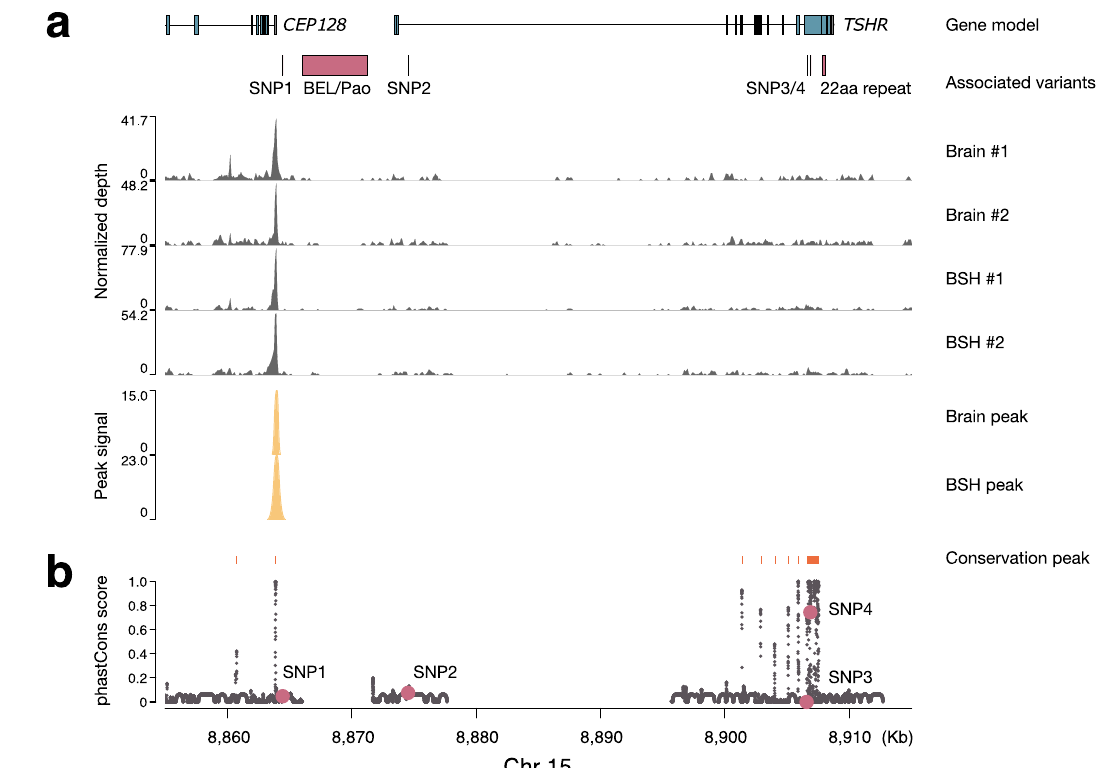
Fig. 3 ATAC-seq and sequence conservation analysis for the herring TSHR locus. a ATAC-seq signals in herring hypothalamus and saccus vasculosus (BSH) and brain without BSH (brain). Genomic locations of two annotated genes at this locus, CEP128 and TSHR , are indicated together with the six highly differentiated variants between spring- and autumn-spawning herring, including two non-coding SNPs (SNP1 and 2), two coding SNPs (SNP3 and 4), the 5.2 kb BEL/Pao structural variant and the 22aa copy number variant at the C terminus of herring TSHR. b Sequence conservation represented by the phastCons score calculated using data from 12 fi sh